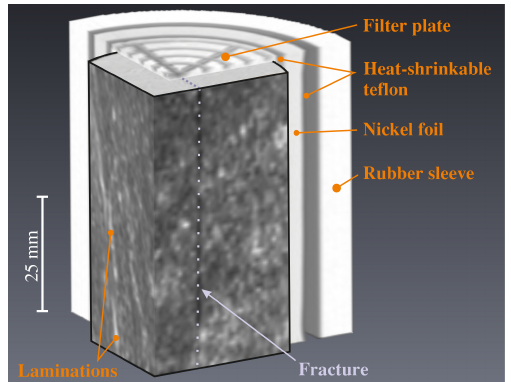
Figure 3. The computed tomography (CT) image of the rock sam- ple with a rescaled voxel dimension (0.25 × 0.25 × 0.25mm 3 ). The upper filter plate, the units of the core holder and lamination of the sample are highlighted in orange. The fracture is indicated by a dot- ted purple